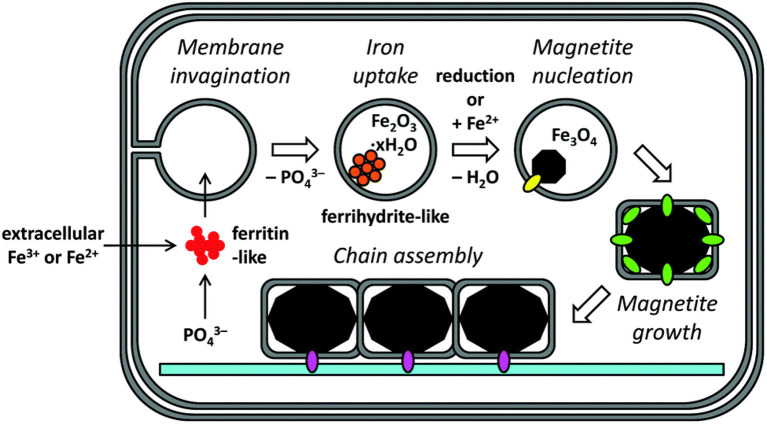
Biomineralizatimodel of magnetite in cellular magnetosomes. Reproduced with permission from Mirabello et al. (2016).